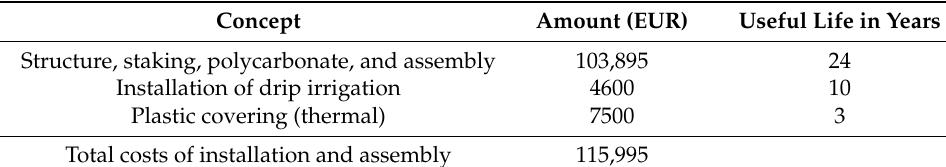
Table 11. Total costs of installation and